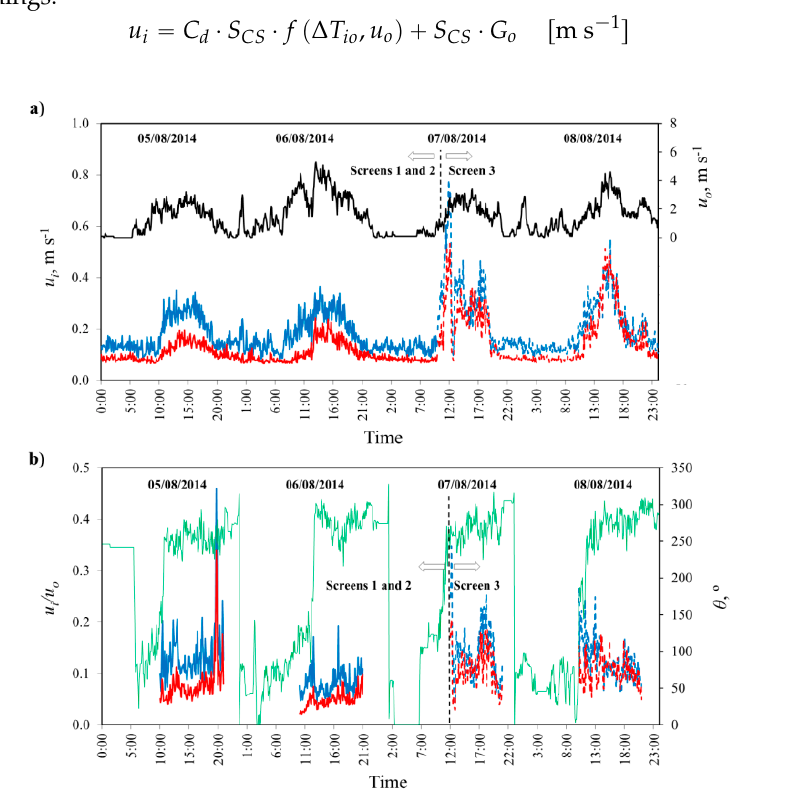
Figure 5. Temporal evolution of the outside wind speed u o ( ― ) and inside air velocity u i (m·s − 1 ) ( a ) and wind direction ( ― ) and normalised velocity u i / u o ( b ). Inside velocities measured in the centre of sector E with screen 1 ( ― ), sector W with screen 2 ( ― ), sector E with screen 3 ( - - - ) and sector W with screen 3 ( - - - ).